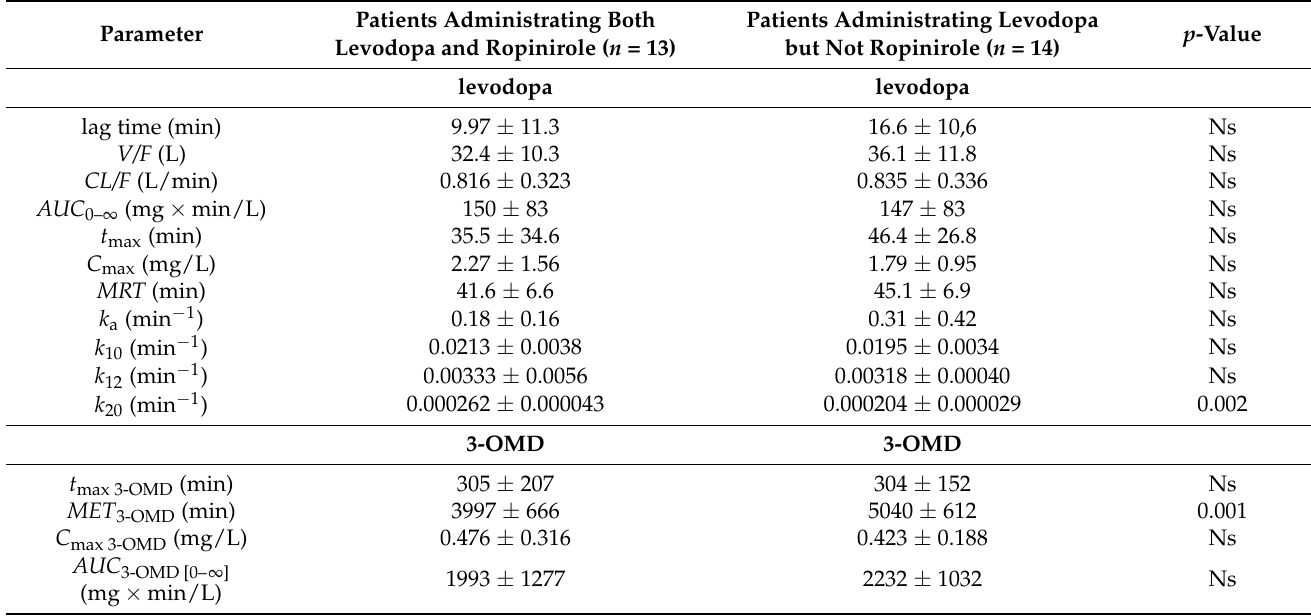
Table 4. Means of pharmacokinetic parameters of levodopa and 3-OMD after administration levodopa and ropinirole ( n = 13) and levodopa but not ropinirole ( n = 14).